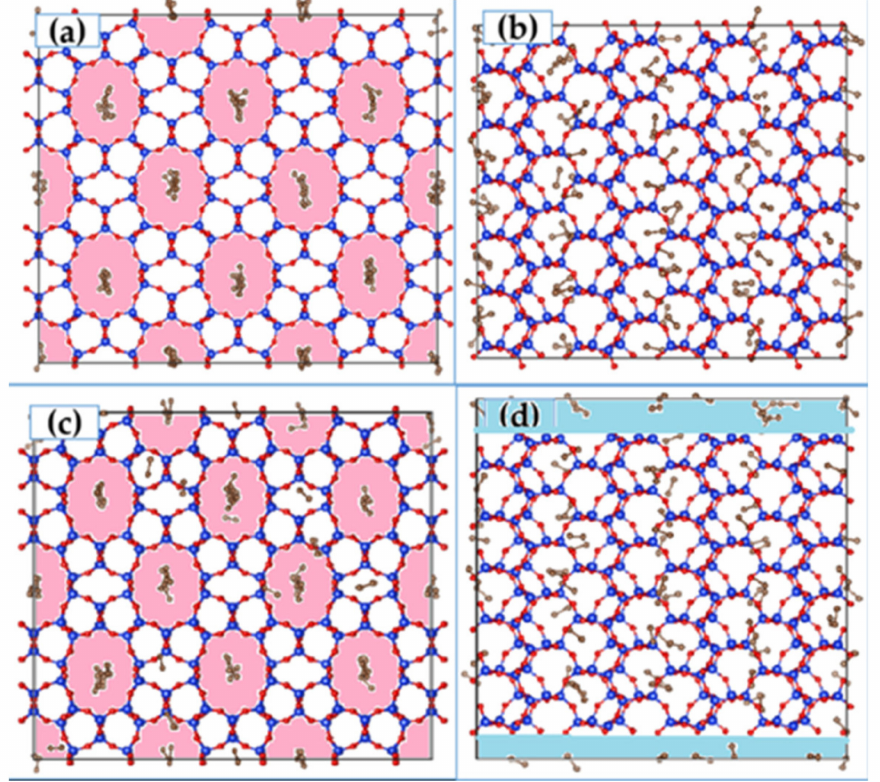
Figure 1. Snapshots from the simulation of ethane in ZSM-22 in X–Y ( a , c ) and X–Z ( b , d ) planes. ( a , b ) show the ZSM-22 simulation cell without any empty space inserted, while the simulation cell in ( c , d ) has empty space inserted in the Z-direction. Elliptical channels running in the Z-direction can be seen in the X–Y plane ( a , c ) (regions colored in light pink) whereas the empty space inserted in the Z-direction can be seen in ( d ) (slab-like regions highlighted in light blue). Blue, red, and gray spheres, respectively, represent Si, O, and CH 3